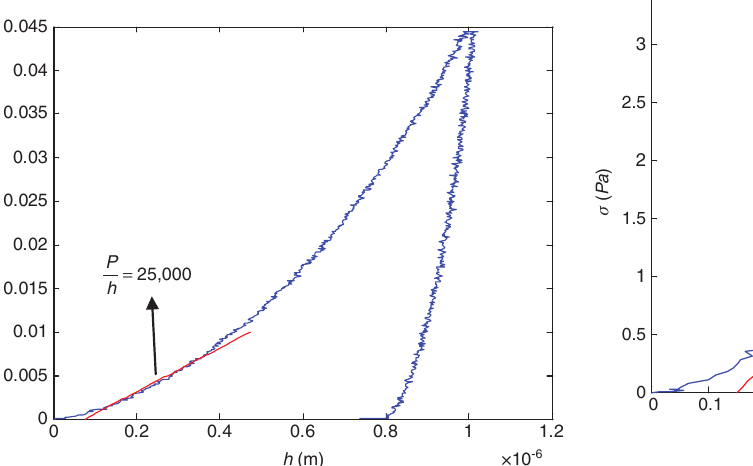
Figure 2: Typical curve of nanoindentation in marble. The red line has a slope P/h = 25,000.